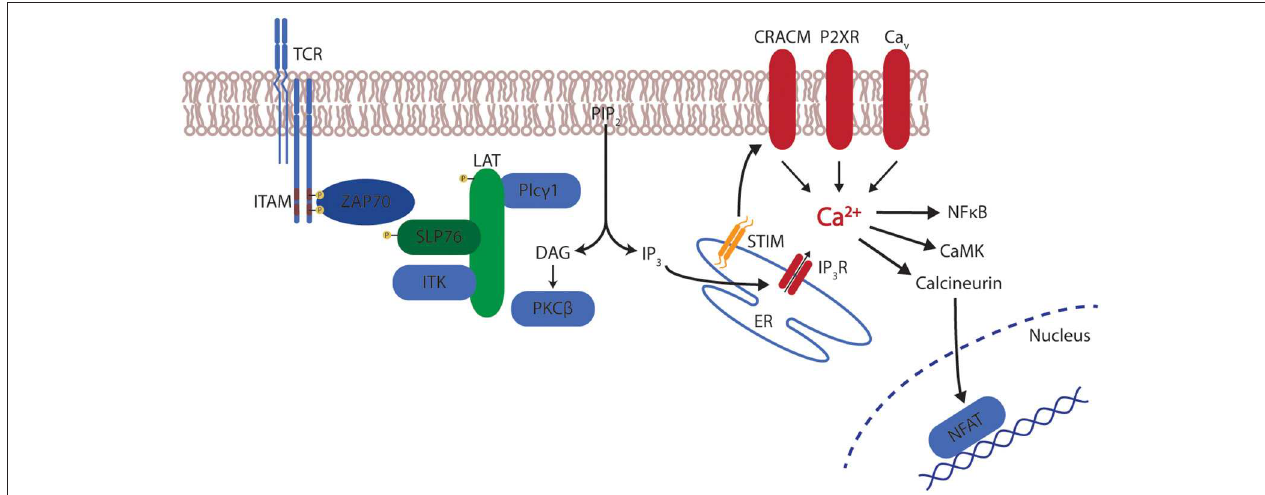
FIGURE 1 | T cell receptor signaling and calcium. After stimulation of the T cell receptor (TCR), the signal is relayed via immunoreceptor tyrosine-based activation motifs (ITAM) leading to the recruitment of zeta-activated protein 70 (ZAP70) and the phosphorylation of linker for activation of T cells (LAT). LAT recruits SH2-domain containing leucocyte protein of 76 kDa (SLP-76) which activates Interleukin-2 inducible tyrosine kinase (ITK). Subsequently, phospholipase C gamma 1 (PLC- γ 1) creates diacylglycerol (DAG) and inositol triphosphate (IP 3 ) by cleaving phosphatidylinositol triphosphate (PIP 2 ). DAG activates protein kinase C (PKC), IP3 stimulates a calcium release from the endoplasmic reticulum (ER) via the IP3 receptor (IP3R). This calcium release induces the interaction of stromal interaction molecule 1 (STIM1) with CRAC modulator 1 (CRACM1). In addition membrane-bound channels from the transient receptor potential (TRP) family, P2X receptors or voltage-gated calcium-channels (Ca v ) contribute to calcium mobilization. The resulting calcium elevation activates several signaling proteins such as calcineurin and its target nuclear factor of activated T cells (NFAT), nuclear factor κ B (NF κ B) or the Ca + 2 calmodulin-dependent kinase (CaMK).